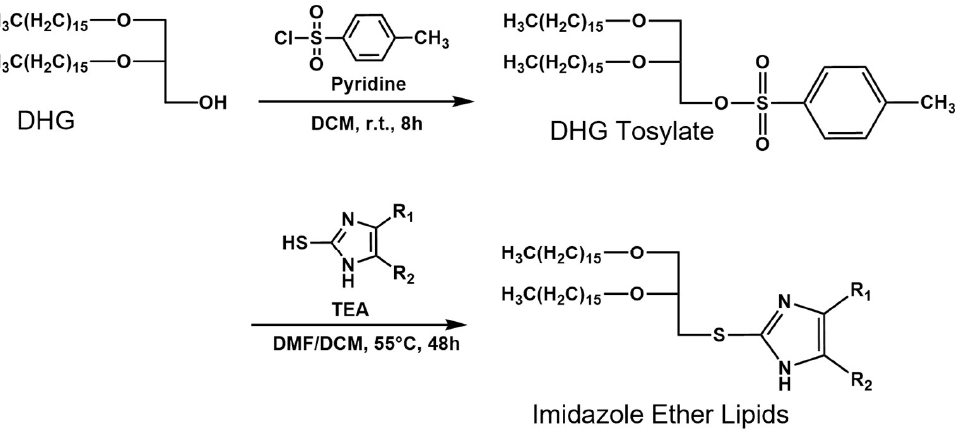
Figure 3. Synthesis of imidazole-based, pH-sensitive lipids.